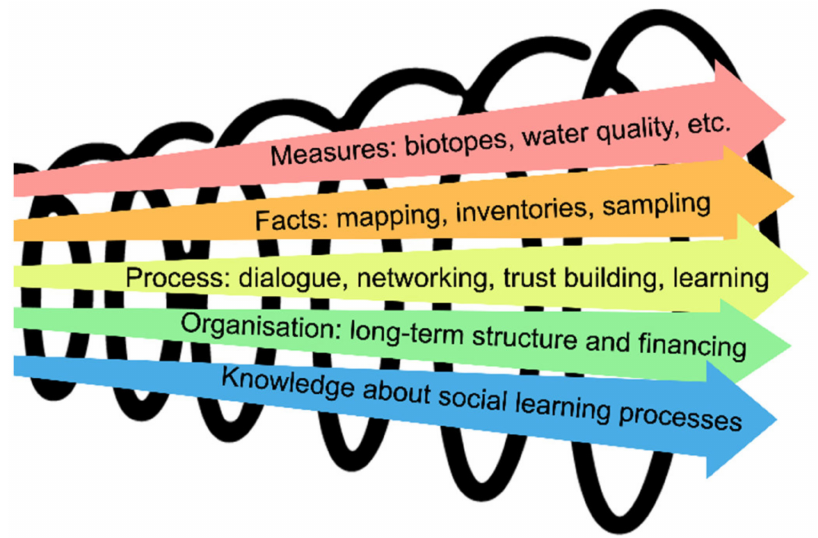
Figure 6. Different types of results generate different types of knowledge. Source: Inspired by Nolbrant [49]. Published with permission by